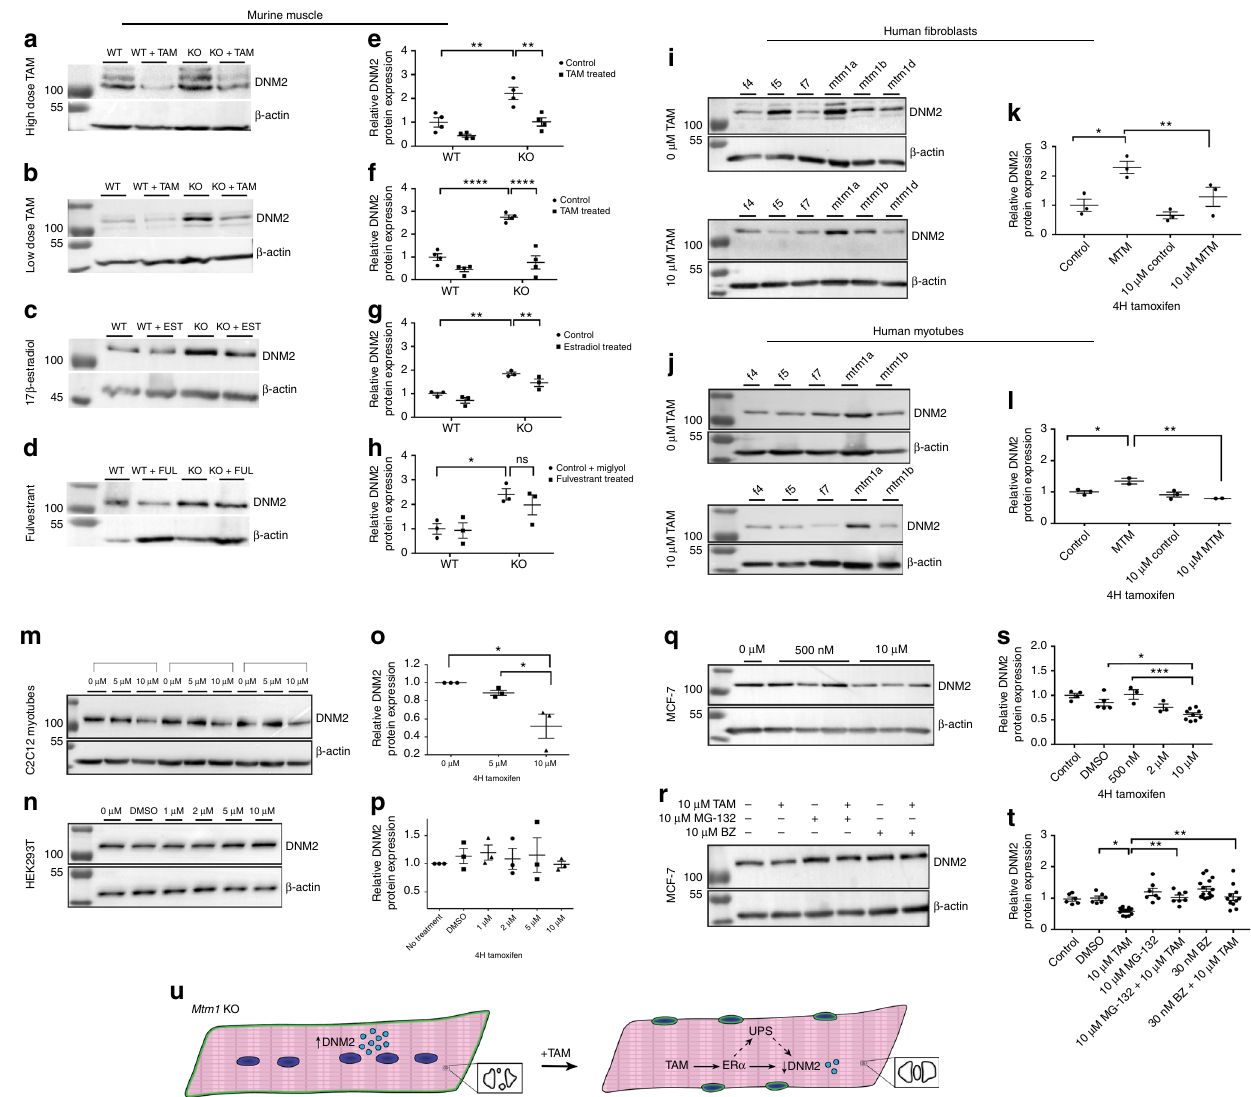
Fig. 8 Tamoxifen reduces dynamin-2 protein level in vivo and in vitro. a – d Representative western blots for dynamin-2 (DNM2) ( β − actin loading control) for Mtm1 KO mice ± tamoxifen (TAM). a , b 17 β -estradiol c and fulvestrant d . e – h DNM2 protein levels are increased in Mtm1 KO and reduced by TAM and estradiol treatments. Quanti fi cation determined by densitometry (standardized to β -actin) and represented as fold difference from WT ( n = 4 mice per group for high and low-dose TAM; n = 3 for 17 β -estradiol and fulvestrant); graphs represent 4 and 3 technical replicates respectively, and mean ± SEM). i – q Representative western blots for DNM2 in various cell culture models, with accompanying quanti fi cation (presented as fold difference vs. average for untreated cells). i – l DNM2 is increased in human MTM patient fi broblasts ( n = 3 cell types per group for control and MTM) and transdifferentiated myotubes ( n = 3 cell types per group for control and n = 2 for MTM) and decreased with TAM; graphs represent three technical replicates and mean ± SEM. k , l DNM2 can be reduced with TAM in C2C12 myotubes m , o and MCF-7 cells q , s both of which express ER α (Supplementary Figure 12A), but not in HEK293T cells n , p which do not (Supplementary Figure 12B); graphs represent three technical replicates and mean ± SEM. r Representative western blot for DNM2 for MCF-7 cells treated with 10 µ M MG-132 and 30 nM Bortezomib (BZ) ±10 µ M TAM; graphs represent 6 – 15 technical replicates and mean ± SEM. t Both UPS inhibitors block TAM ’ s effect on DNM2, as revealed by densitometric quanti fi cation (values standardized to β -actin and represented as the fold difference from the average of untreated control). Statistical analyses were conducted by two-way ANOVA for mouse experiments, and one-way ANOVA for in vitro experiments, followed by Tukey ’ s multiple comparisons post test. * p ≤ 0.05, ** p ≤ 0.01, *** p ≤ 0.001, **** p ≤ 0.0001. Of note, a full listing of all data points for a – r is presented in Supplementary Table 5. u Schematic representing proposed mechanism of action of TAM in Mtm1 KO